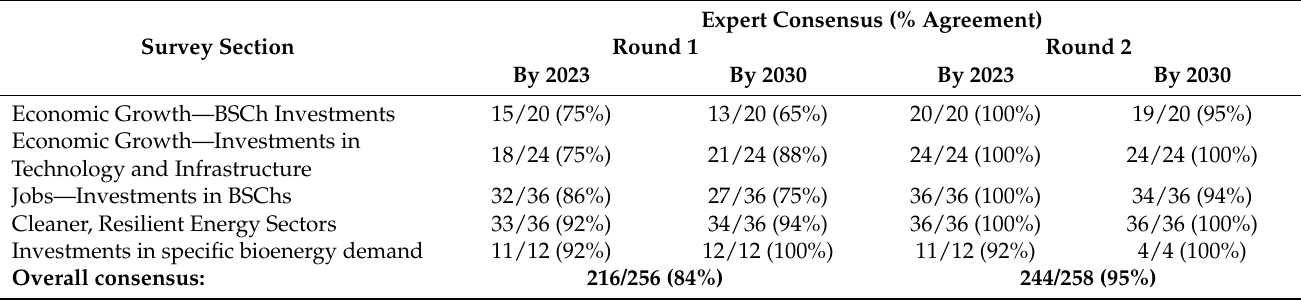
Table 5. Survey results and consensus reached by Delphi round and survey section.